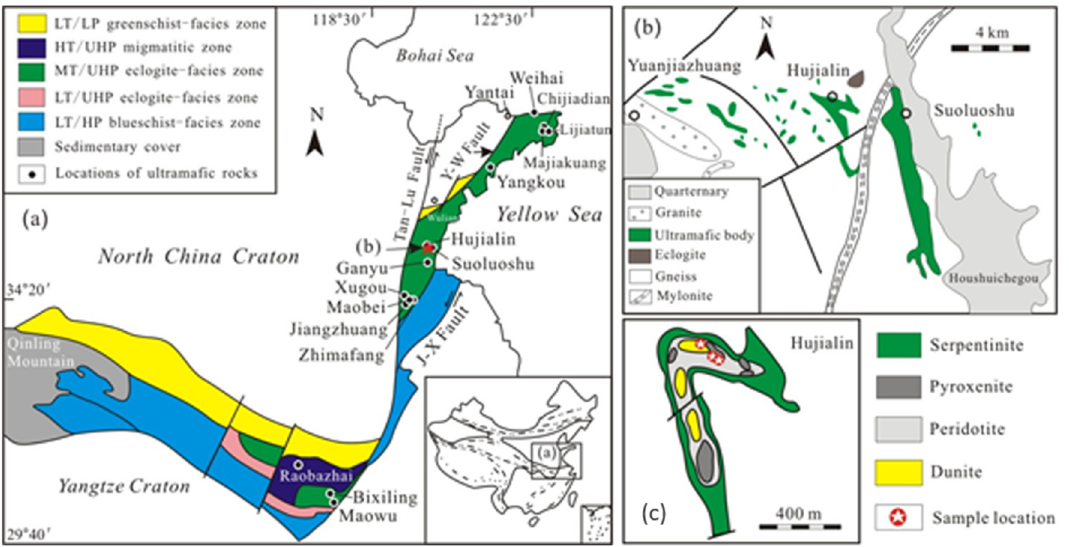
Figure 1. ( a ) A sketch map showing the framework of the Dabie-Sulu orogenic belt and the distribu- tion of orogenic ultramafic rocks (modified after Zheng et al. [13]; Chen et al. [14]). ( b ) Geological sketch map of the Rizhao area, showing the position of ultramafic rocks in Hujialin (modified after Zhang and Liou [15]). ( c ) Outcrop map of the Hujialin ultramafic rocks (after Zhang and Liou [15]). Abbreviations: Y-W Fault = Yantai-Wulian Fault; J-X Fault = Jiashan-Xiangshui